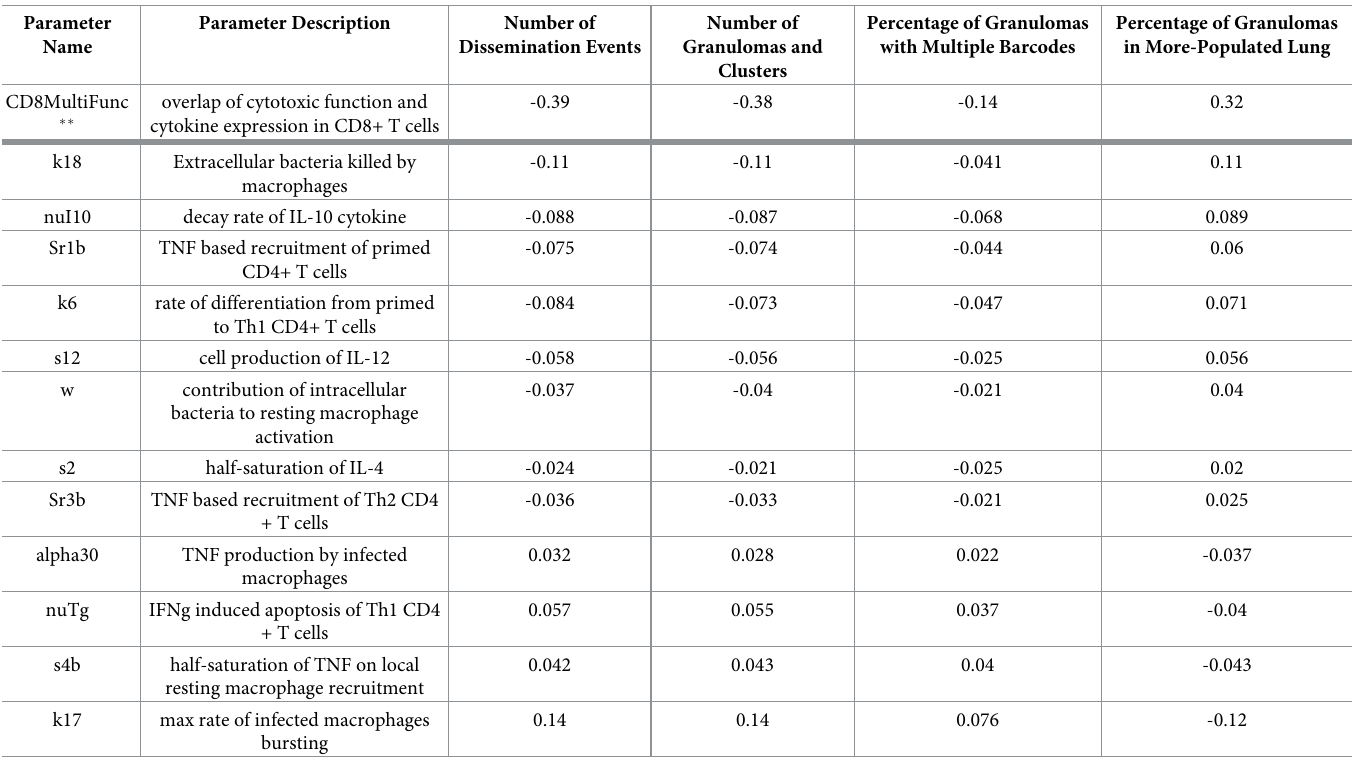
Table 2. Sensitivity Analysis reveals global drivers of dissemination outcomes. PRCCs are shown for each parameter, showing a significant impact on each of the 4 MultiGran whole lung simulation outcomes at the end of the simulation. �� Excluding parameter CD8MultiFunc , the overlap of cytotoxic function and cytokine expression in CD8+ T cells, 12 other parameters were also identified as having a significant impact on each of 4 MultiGran whole lung simulation outcomes at the end of the simula- tion. All PRCCs shown are significant to p <